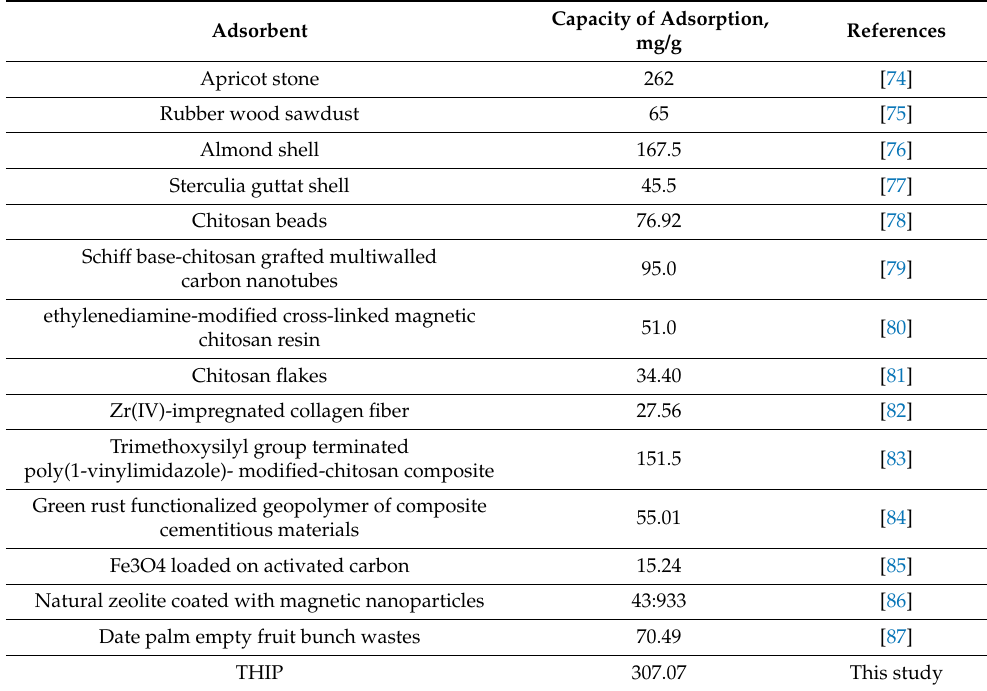
Comparison study of the Cr(VI) adsorption capabilities by TIHP with the other different